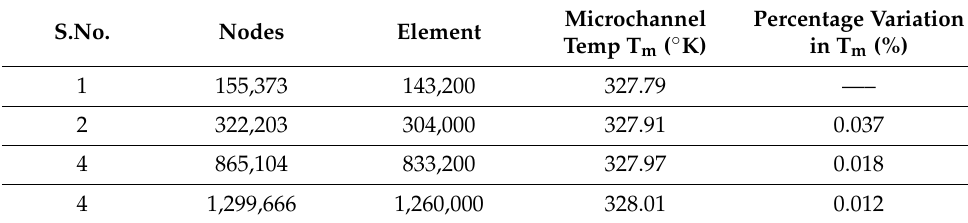
Figure 3. The structured meshing of the microchannel. Table 3. Grid independent